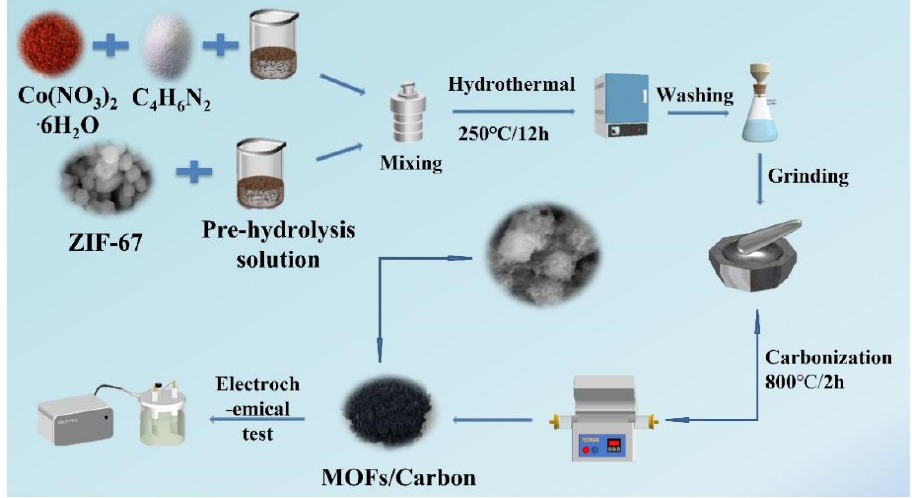
Figure 1. The schematic image of samples.